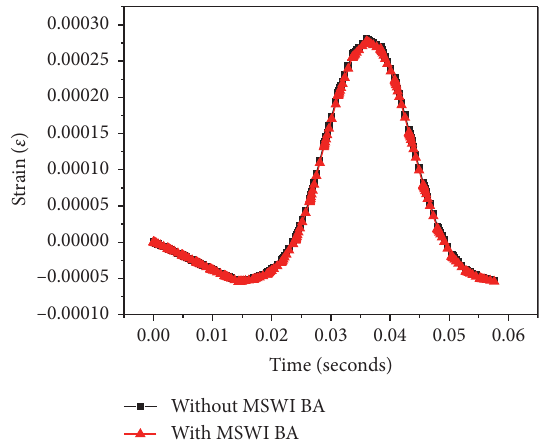
Figure 11: Strain at underside of HMA layer.